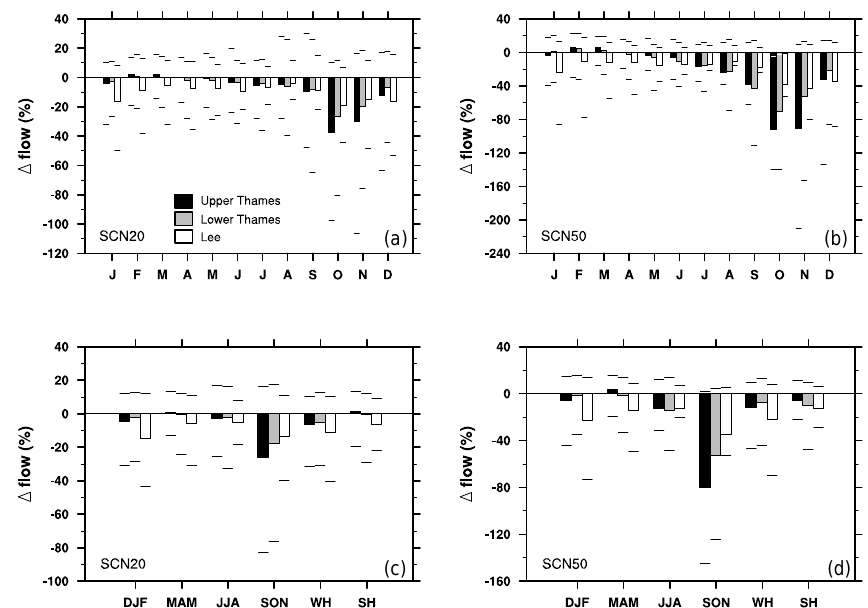
Figure 7. Percentage change in Upper Thames, Lower Thames, Lee catchments for monthly river flows for (a) SCN20, monthly flows, (b) SCN50, monthly flows, (c) SCN20, seasonal flows, (d) SCN50, seasonal flows (standard seasons plus winter half year (WH) and summer half year (SH)). The bars denote the median change from the 100-member ensemble, the upper and lower horizontal lines indicate the ensemble 90th and 10th percentiles,